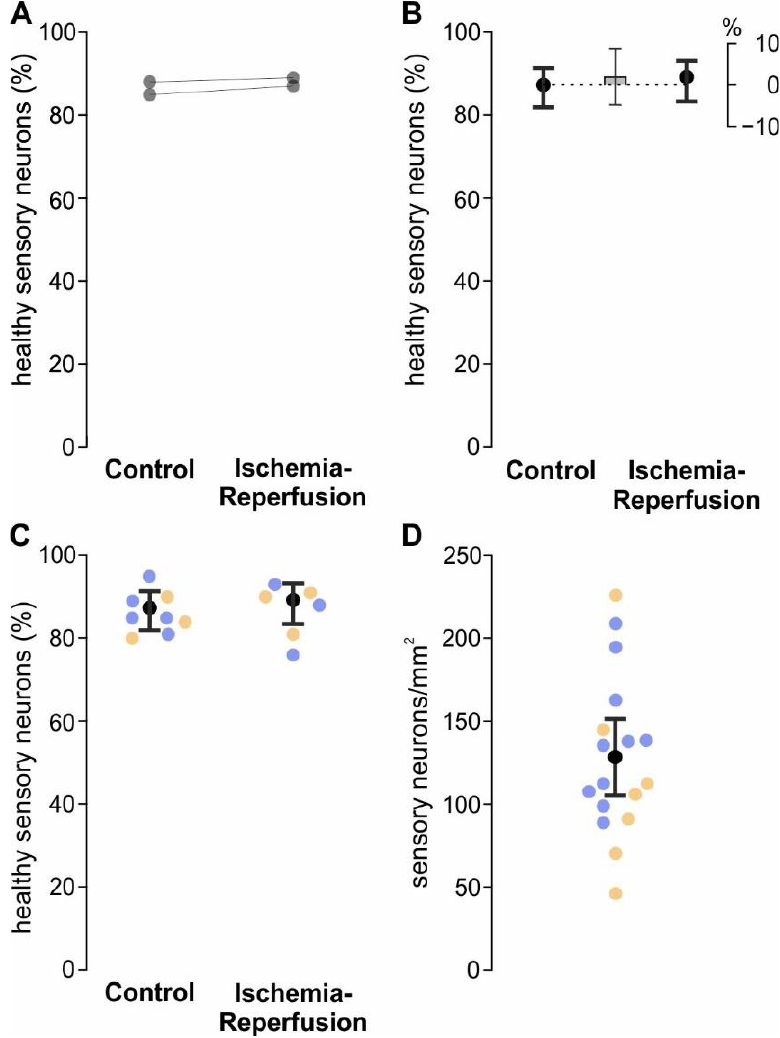
Figure A5. Sensory neurons showed similar survival in ischemia-reperfusion as in control conditions. ( A ) Percentage of healthy sensory neurons at the end of the cellular model for IR, analysed by Annexin V and 7-AAD fluorescence. Every dot represents the mean of one experiment, experiments conducted in parallel are linked. ( B ) Estimated survival probabilities are shown as black dots ± 95% CI, the estimated difference ± 95% CI is shown as grey bar. IR conditions did not change the estimated survival of sensory neurons ( p = 0.59) with IR leading to a nominal increase of the survival probability of sensory neurons of 2%. ( C ) Percentage of healthy sensory neurons at the end of the cellular model for IR with the dots showing the mean of single wells and the colour the experimental day, differentiating the data of panel a. The black dots represent the estimated survival probabilities ± 95% CI. ( D ) The average number of sensory neurons per mm 2 in co-culture with cardiomyocytes is shown with every dot representing one well and each colour corresponding to an experimental day. The mean is shown as a black dot with ± 95% CI.